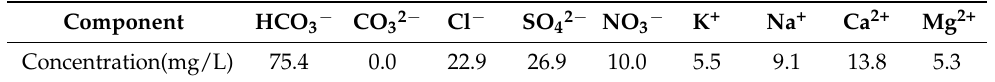
Table 2. Quality characteristics of the tap water.